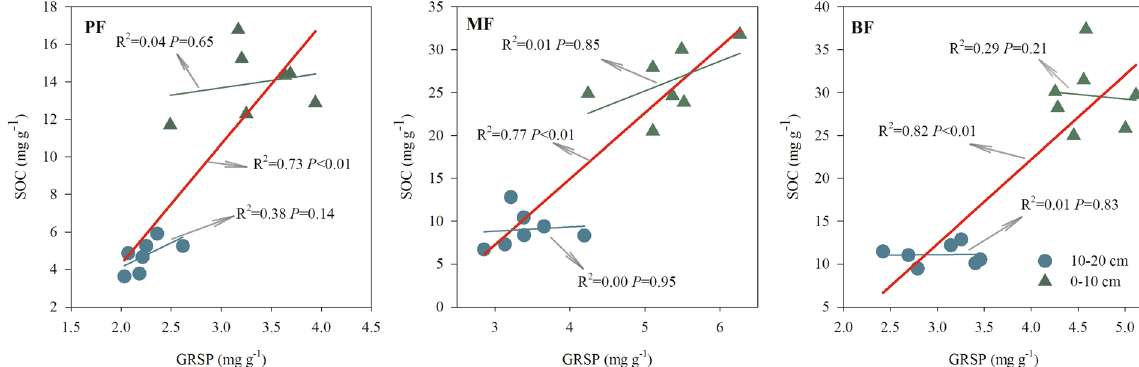
Figure 1. Relationships between glomalin-related soil protein (GRSP) and soil organic carbon (SOC) in the three tropical forests of the Dinghushan Biosphere Reserve, southern China.